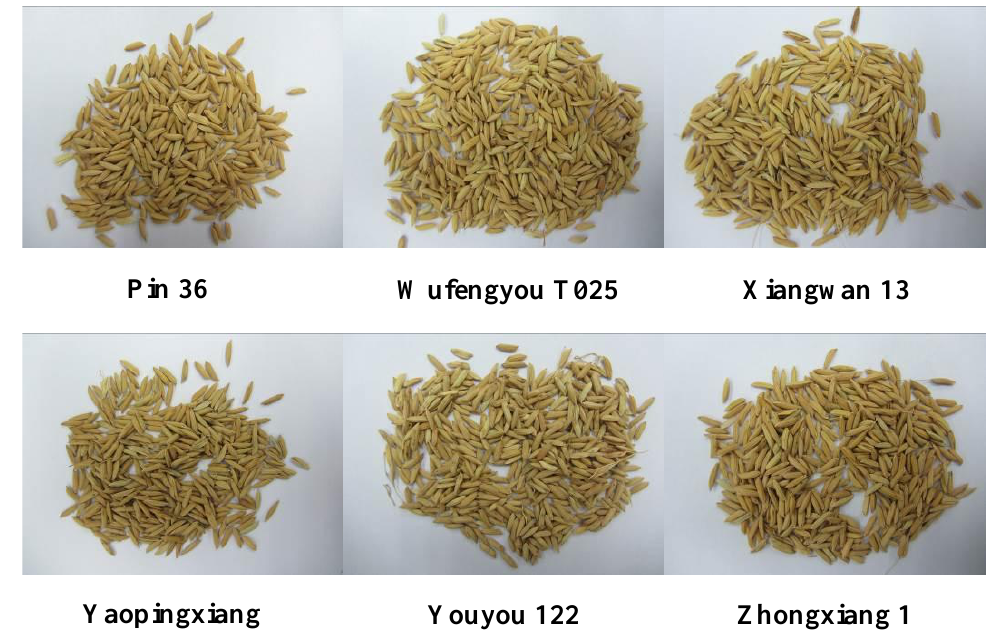
Figure 1. The six studied varieties of rough rice.